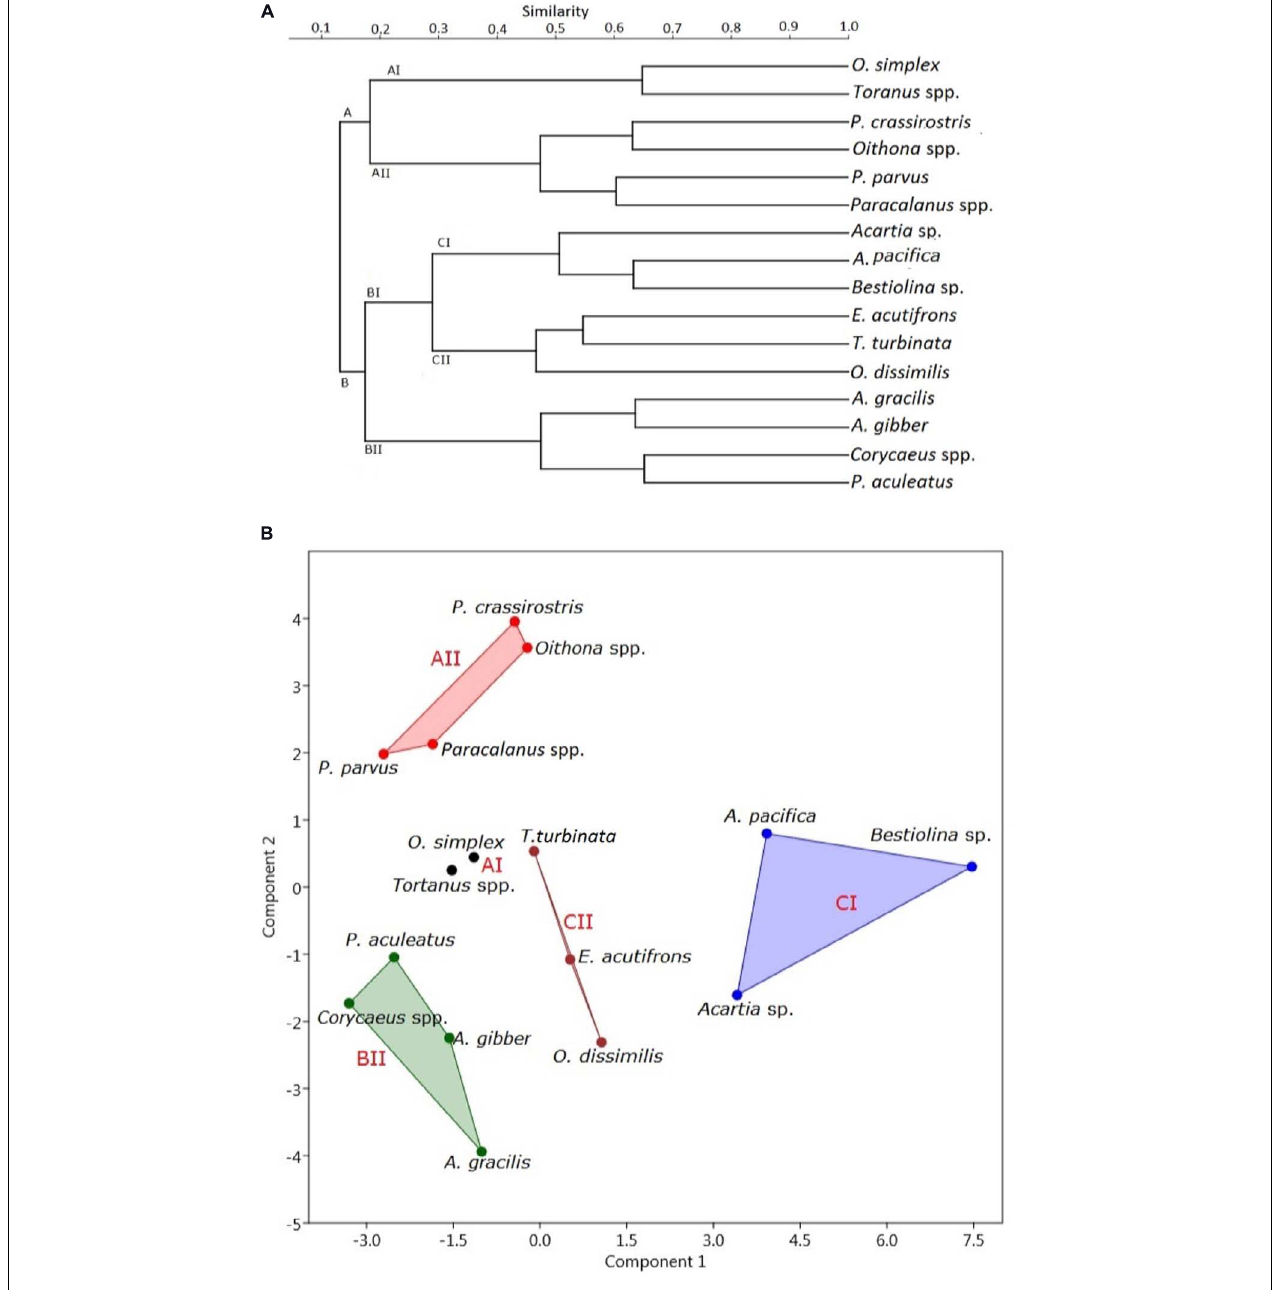
FIGURE 6 | Cluster dendrograms of distribution plotted using the Bray–Curtis similarity distance (A) and nonmetric multidimensional scaling (B) of the 16 most abundant copepod species (comprising 93.44% of the total copepods; full names given in Supplementary Table 2 ) collected on six bimonthly sampling dates in 2014 in the Danshuei River